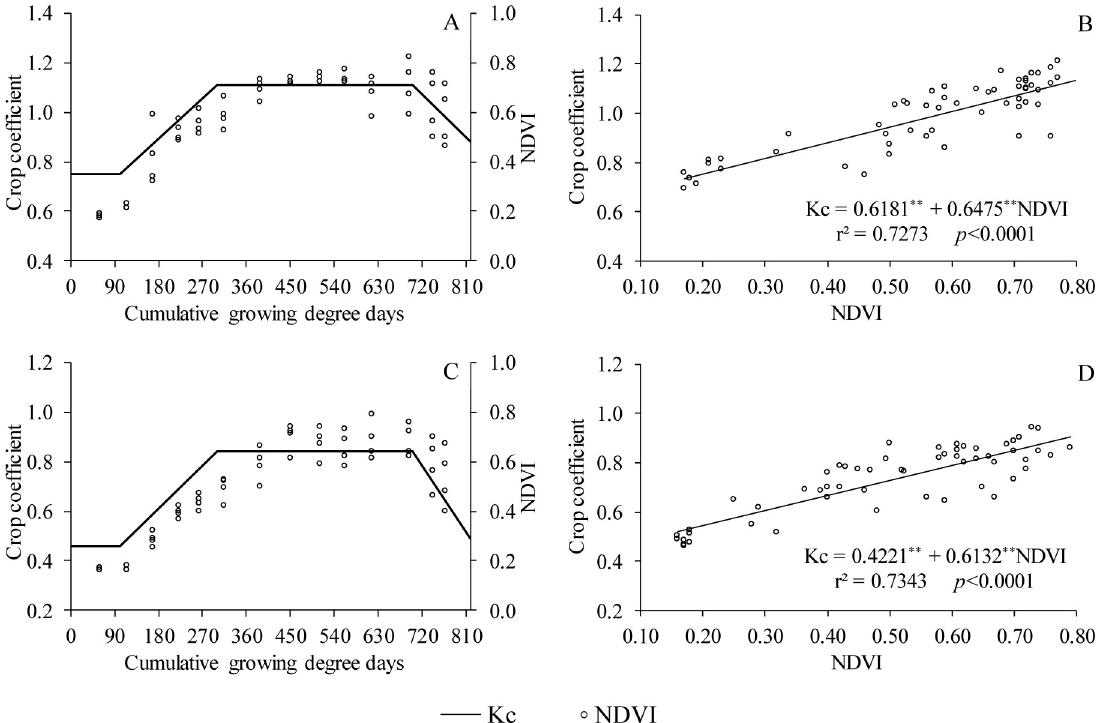
Fig 6. Relationships between the crop coefficients and the normalized difference vegetation index (NDVI) of Italian zucchini in the conventional system (A and B) and cultivated with recycled paper as mulch (C and D). Vic¸osa-MG, DEA-UFV, 2017–2018. �� p < 0.0001.